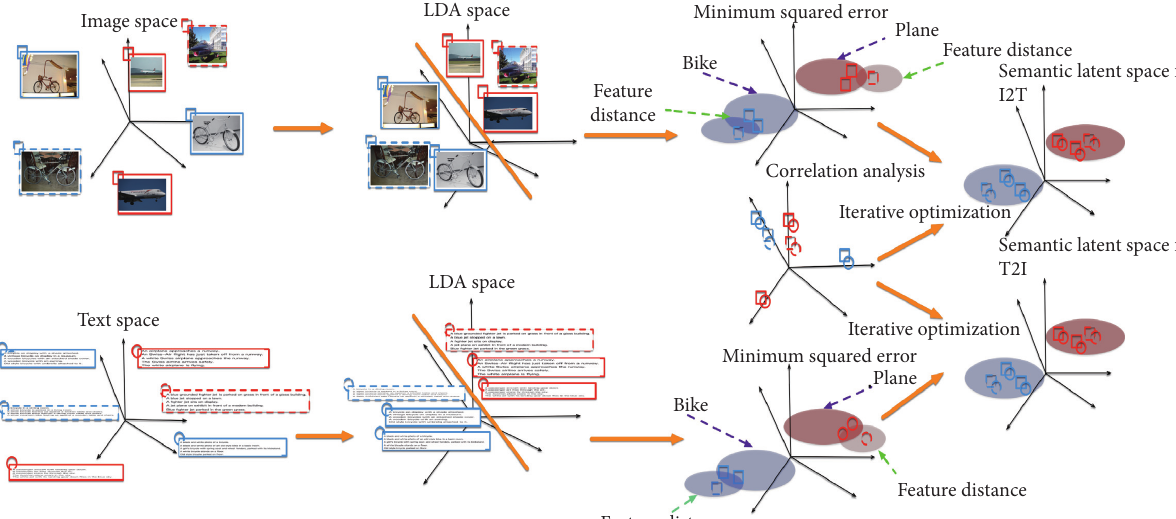
Figure 2: The flowchart of the proposed method. Images are represented by square icons, and the texts are represented by round icons. The images and texts with full lines are labelled data, and the rest are unlabelled data. Different colours indicate different categories. Our method adopts LDA to make different classes separate and make full use of the semi-supervised strategy to maximize the correlation between different modals